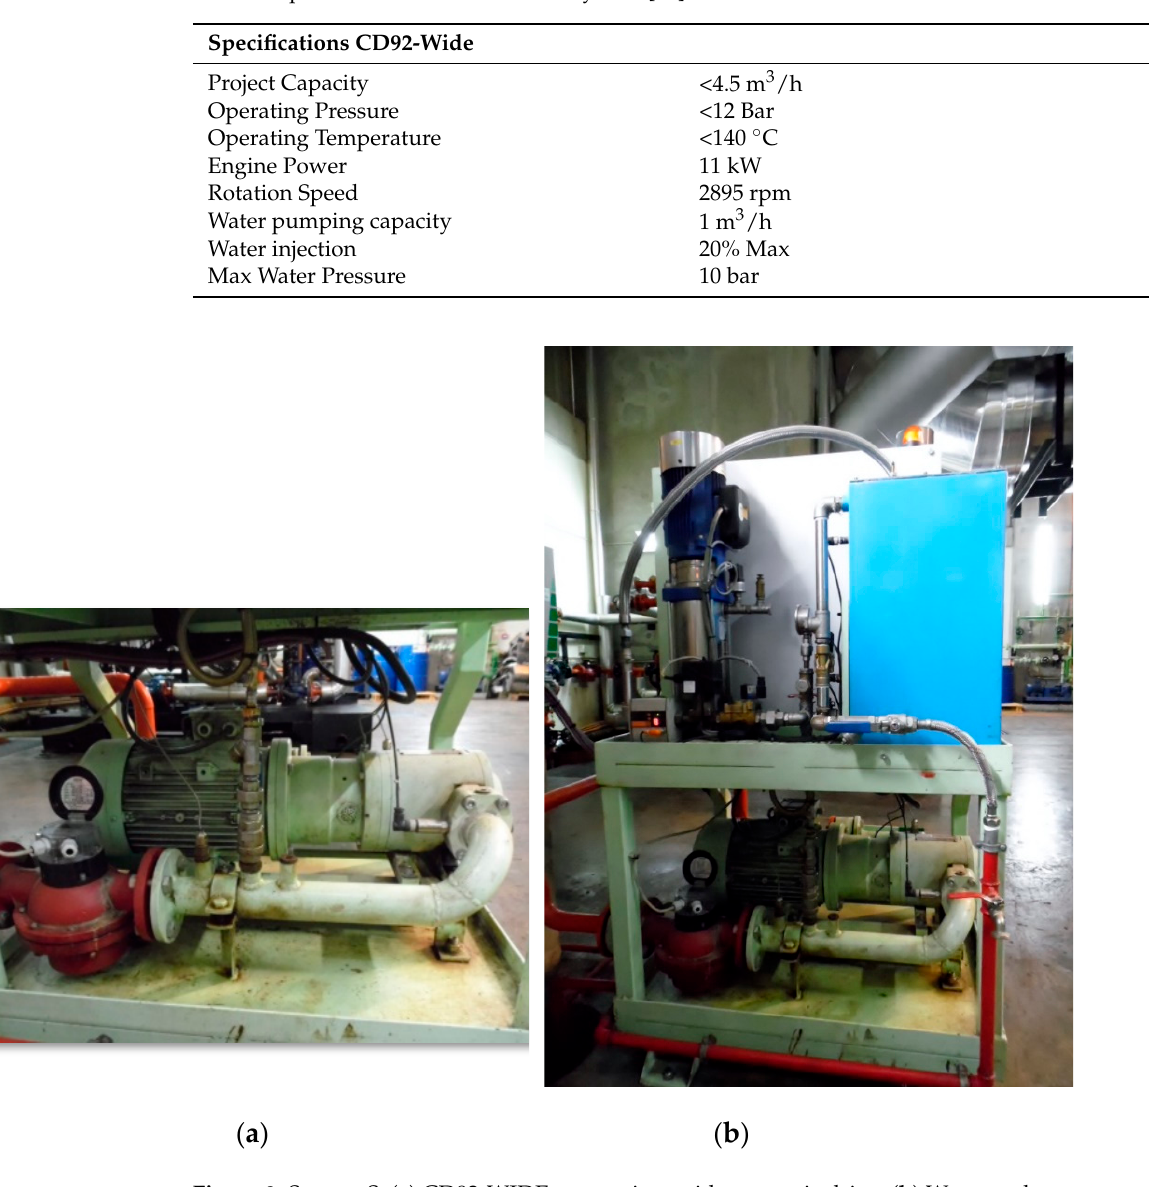
Figure 8. System S. ( a ) CD92-WIDE mycronizer with magnetic drive; ( b ) Water tank, water pump, fuel and water flow meter. The diagram of the S system is represented in Figure